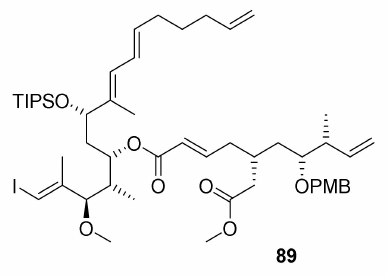
Figure 2. Structure of the potential RRCM substrate